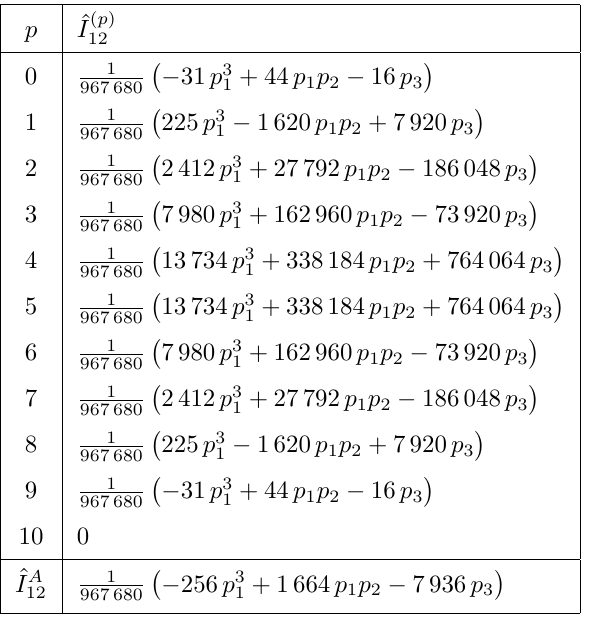
Table 7 . The twelve-form anomaly polynomials for chiral fermionic p -forms in D = 10 .